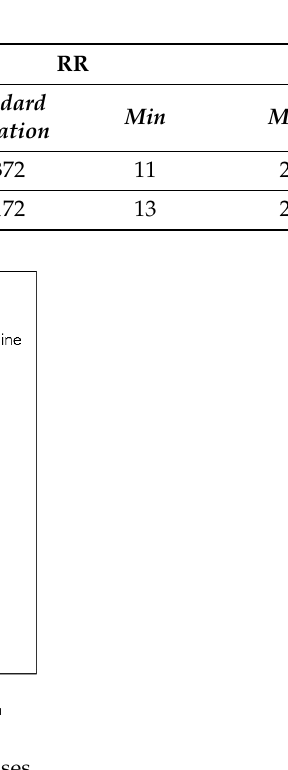
--- Table 8. HRs of different age-groups in different temporal phases under the 24 °C condition. Initial Stage Cold Exposure 10 Min